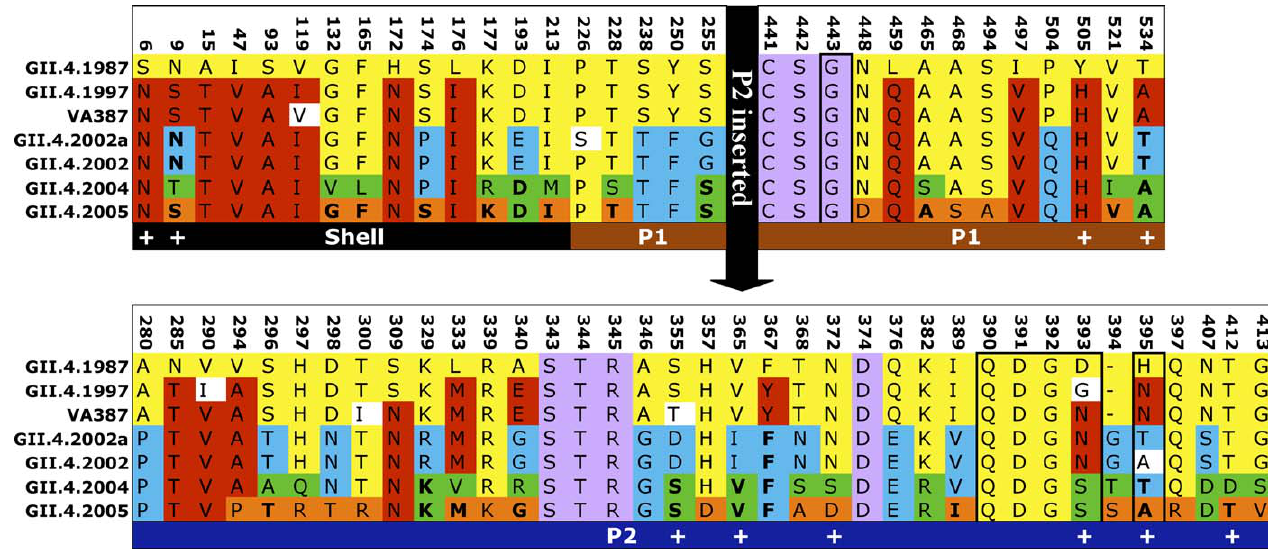
Figure 1. Evolutionary Analysis of Representative GII.4 Strains from 1987 to Present Five major evolutionary patterns were observed in the mutational profiles of the GII.4 sequences, and these are represented by GII.4–1987, GII.4–1997, GII.4–2002, GII.4–2004, and GII.4–2005. Yellow, amino acids present in the late 1980s Camberwell cluster (GII.4–1987); red, changes that occurred to form the Grimsby (GII.4–1997) cluster; blue, changes associated with the Farmington Hills (GII.4–2002) cluster; green, changes specific to the Hunter cluster (GII.4–2004); and orange, substitutions important for the Sakai cluster (GII.4–2005). A second GII.4–2002a sequence is included, as it encodes a single amino acid replacement at positively selected position 395 in the P2 subdomain as compared to GII.4–2002. The P2 region is highlighted in dark blue beneath the amino acids, with the N-terminal and C-terminal flanking regions of heterogeneity noted in black for the S domain and brown for P1. Lavender sites represent residues that hydrogen bond to the ligand at site 1; framed residues have been predicted to interact in a second stabilization domain. Amino acids operating under positive selection are marked below the column with a plus sign. Residues that are not colored represent single amino acid changes that were not seen in other strains in the cluster. Strain VA387 is included for comparison, as it is a Grimsby-like virus with a solved crystal structure of the P domain. Bold residues represent amino acids that reverted to a residue from a previous